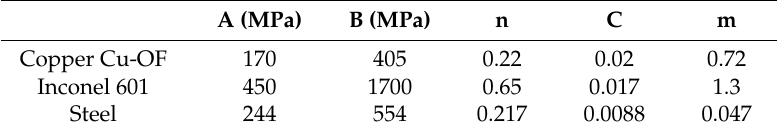
Table 6. Johnson–Cook’s law parameters for different materials [6,9].